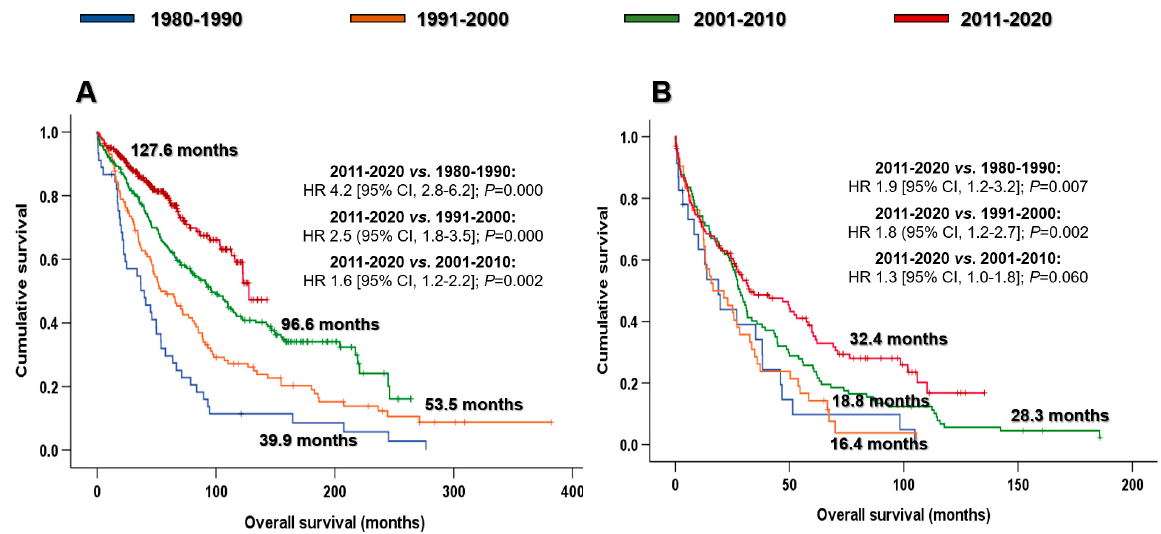
Figure 2. Overall survival by decades and age at diagnosis: ( A ) ≤ 70 years and ( B ) >70 years. Abbreviations: CI: confidence interval; HR: hazard ratio .